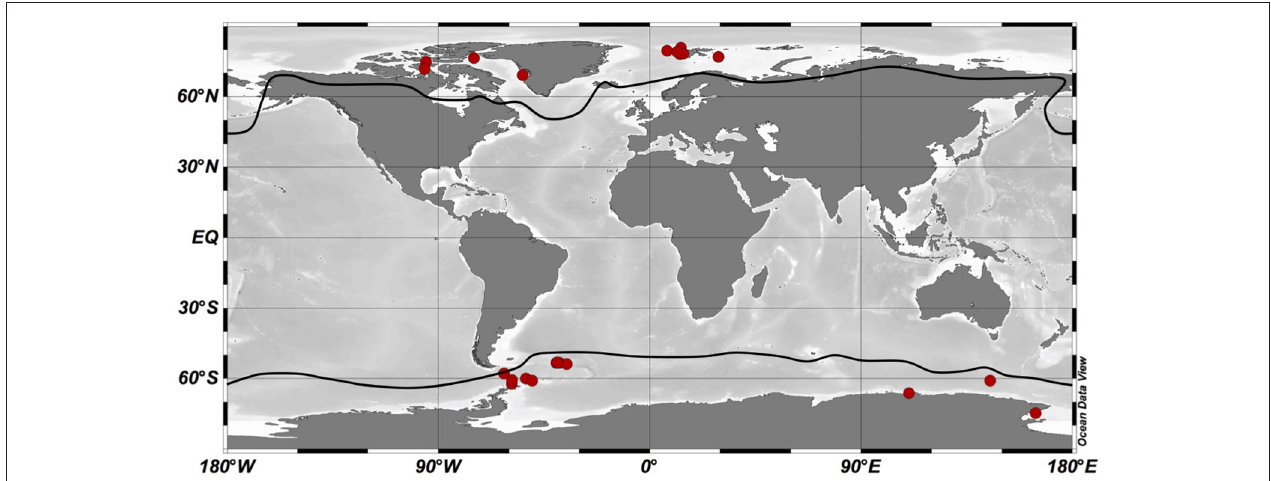
FIGURE 2 | Geographical distribution of optimum temperature data for phytoplankton growth in the Arctic and Southern Oceans. Red dots indicate geographical sites from which phytoplankton species where isolated. Dark lines represent the polar boundaries considered in this study: the 10 ◦ C isotherm for the Arctic Ocean and the Antarctic Convergence for the Southern Ocean. Schlitzer, R., Ocean Data View, http://odv.awi.de, 2015.